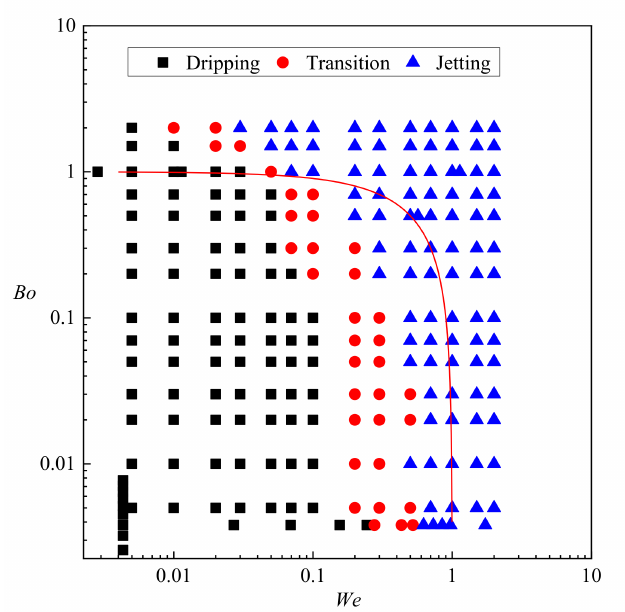
Figure 11. Regime diagram in the coordinates of We and